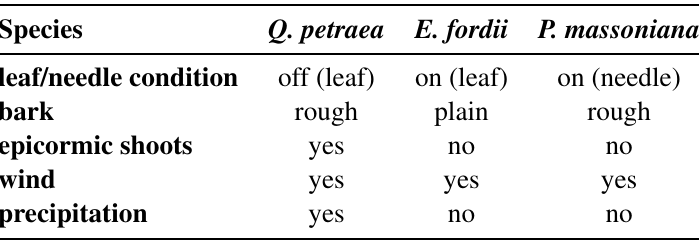
Table 3. Overview of species